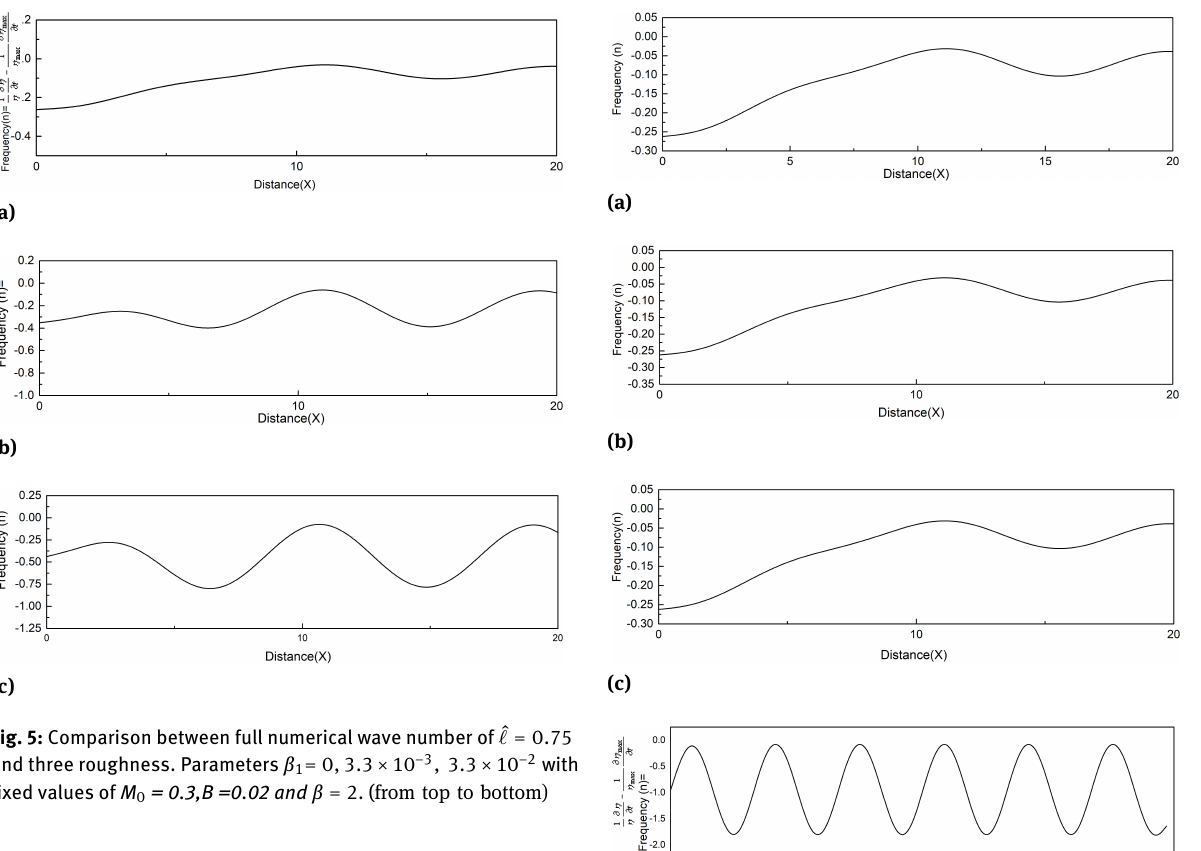
0 = 0.2, 0.25, 0.3, 0.35 −6 . 1 = 3.3 × 10